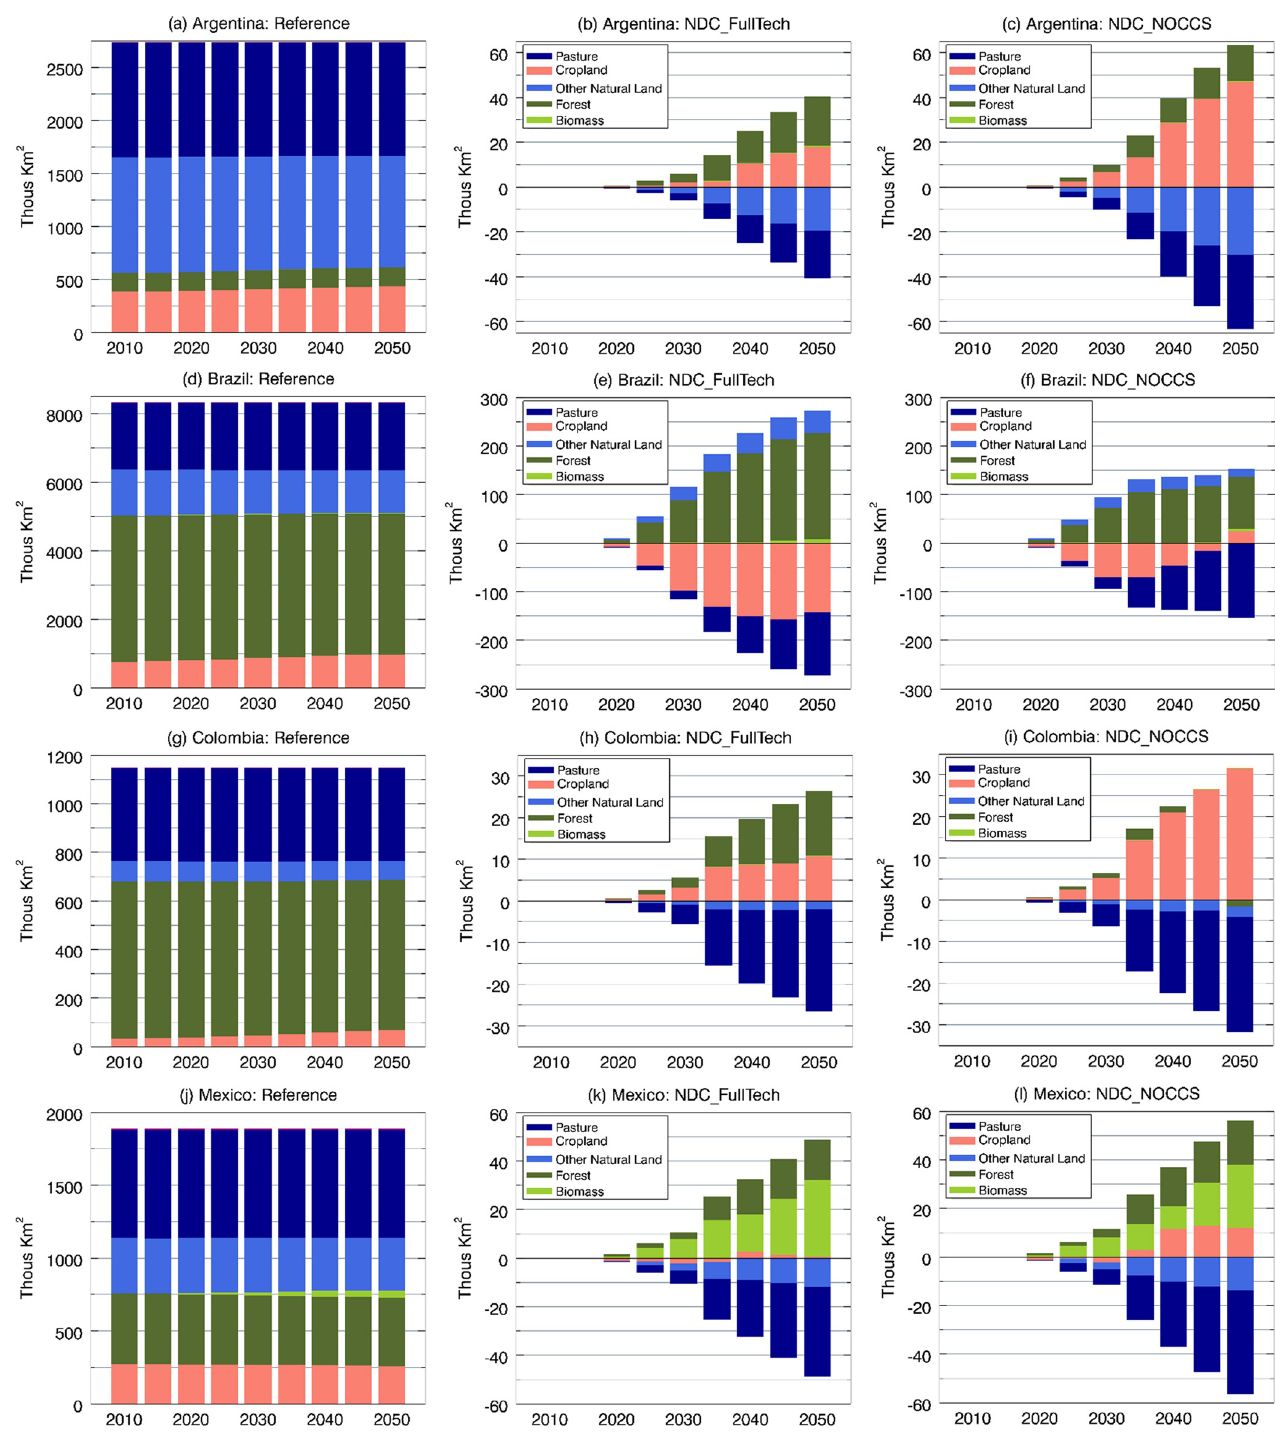
Fig 3. Land allocation (thous. Km 2 ) under the Reference ((A), (D), (G), and (J)). Difference in land allocation between the NDC_FullTech and the reference pathways in (B) Argentina, (B) Brazil, (H) Colombia, and (K) Mexico. Difference in land allocation between the NDC_NOCCS and the reference pathways in (C) Argentina, (F) Brazil, (I) Colombia, and (L) Mexico.